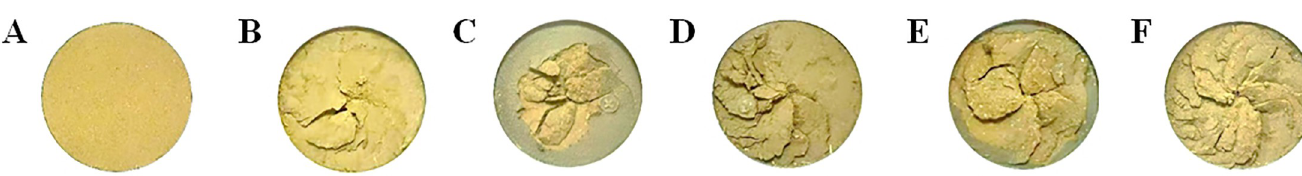
PLOS ONE | https://doi.org/10.1371/journal.pone.0263676 February 7,